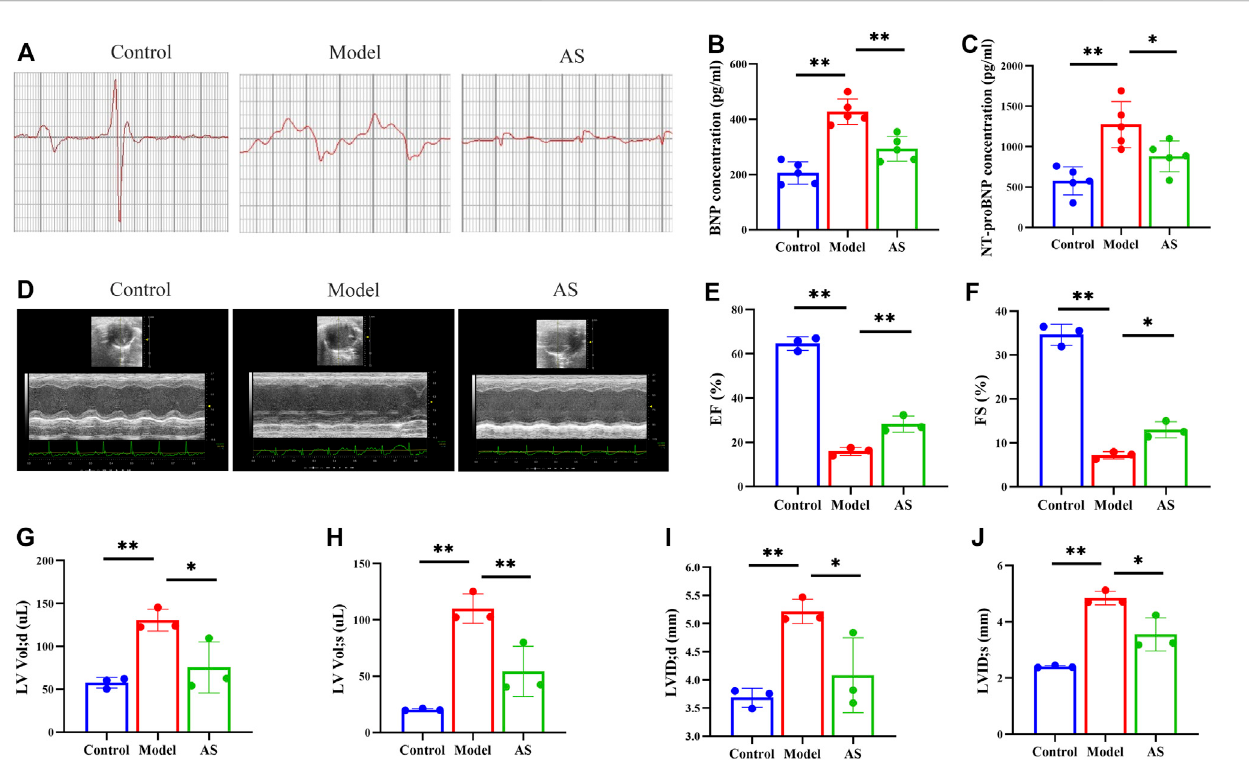
FIGURE 1 ASreducesMIandprotectscardiacfunction. (A) RepresentativeimagesofMiceelectrocardiogram. (B) QuantitativeanalysisofBNPconcentration,n=5. (C) QuantitativeanalysisofNT-proBNPconcentration,n=5. (D) Representativeimagesofmiceechocardiography. (E) QuantitativeanalysisofEF(%),n=3. (F) Quantitative analysis of FS (%), n = 3. (G) Quantitative analysis of LVVd; d (uL), n = 3. (H) Quantitative analysis of LVVd; s (uL), n = 3. (I) Quantitative analysis of LVID; d (mm), n = 3. (J) LVID; s (mm), n = 3. Results are expressed as mean ± SD, ** p < .001, * p <